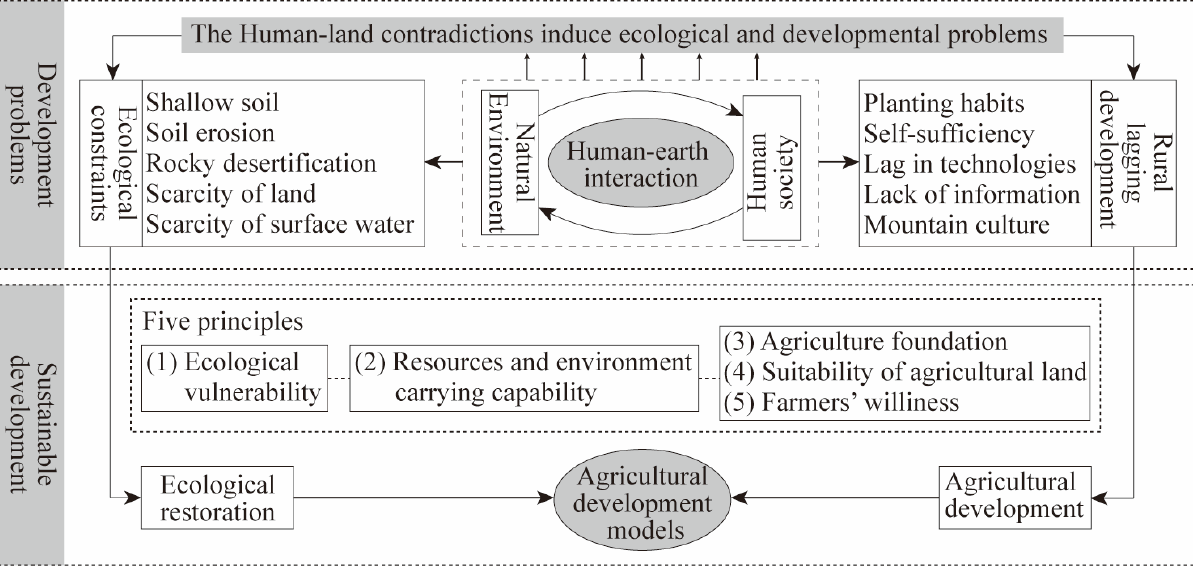
Figure 1. Framework for sustainable development of the karst human–earth areal system.